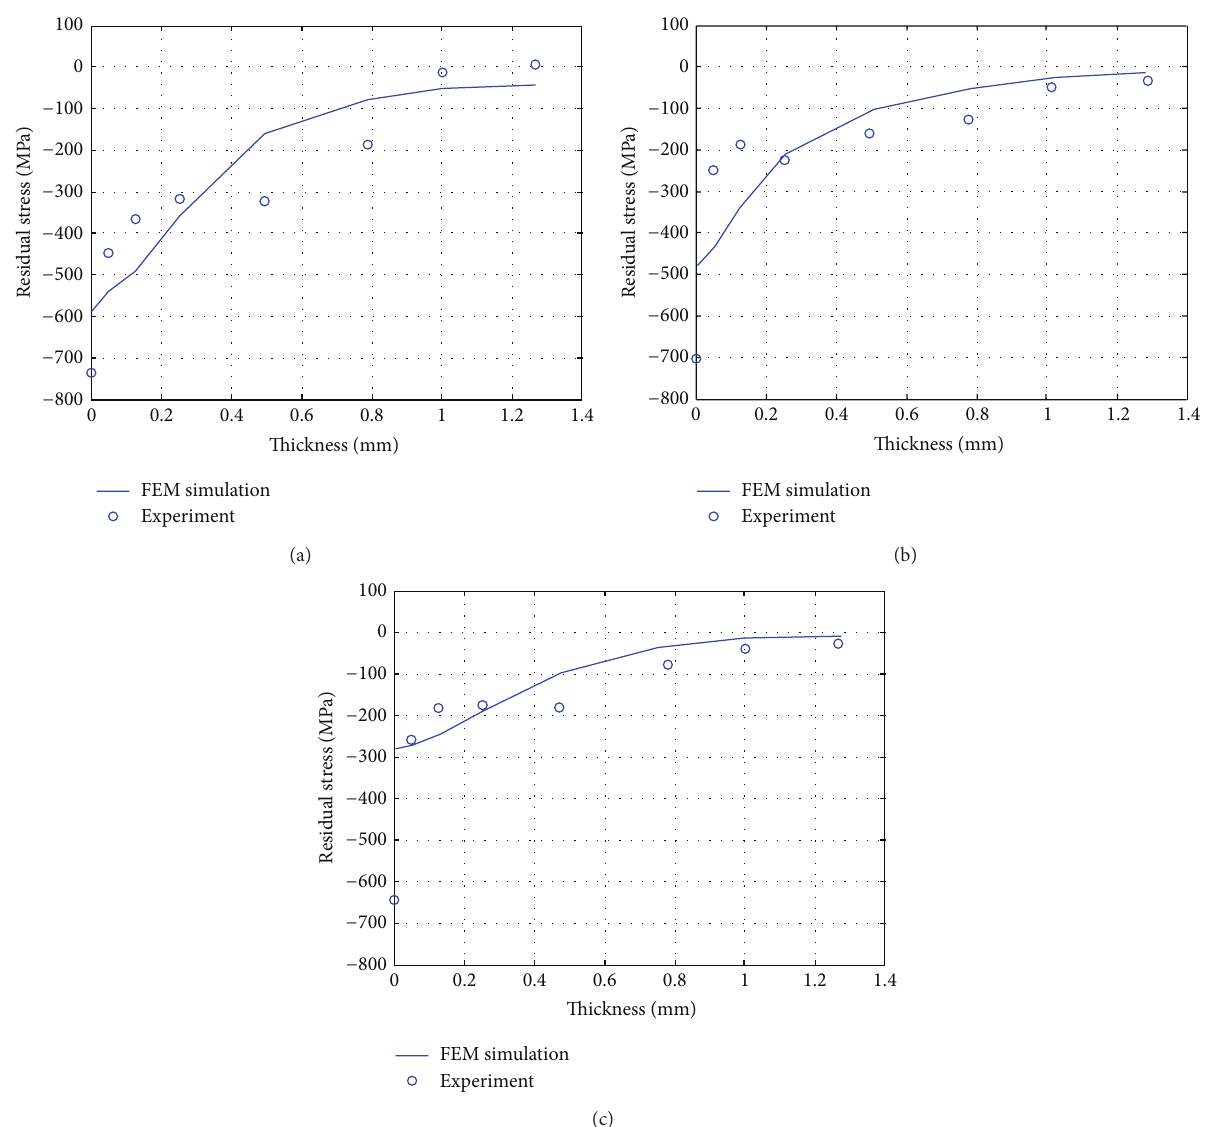
Figure 7: Simulated residual stress profiles with optimized JC constants ( 𝐴 = 130.98 MPa, 𝐵 = 6835.6 MPa, 𝑛 = 0.36465 , 𝐶 = 0.0062 , and = 1.8488 s −1 ) at (a) 6.7 GPa; (b) 5.3 GPa; (c) 4.2 𝜀 0